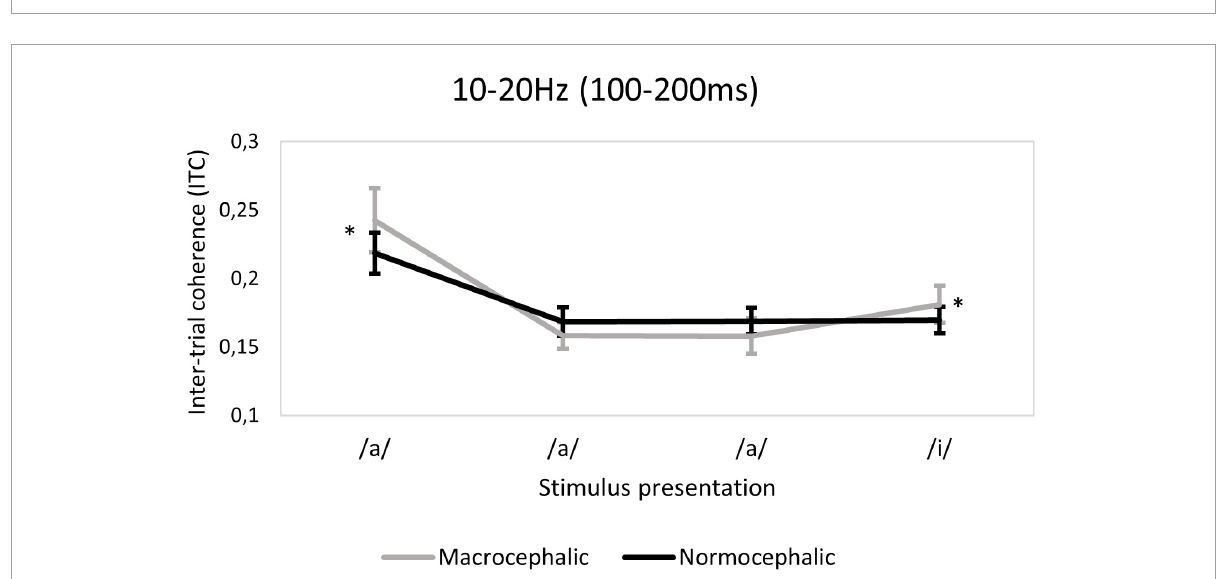
FIGURE6 Ten to twenty Hertz time-frequency window (TFW). Plot demonstrating the group effect, showing the macrocephalic group to have a greater response to the first/a/presentation (corrected p < 0.0006*) compared to the normocephalic group. The plot also illustrates the interaction between group and quadratic slope, showing only macrocephalic infants to have a change detection response associated with the last/i/stimulus (corrected p < 0.0006*). Error bars indicate 95% confidence